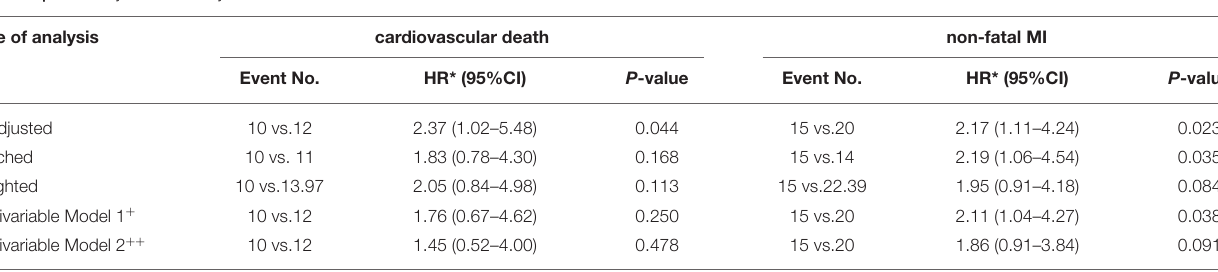
TABLE 4 | Summary of secondary